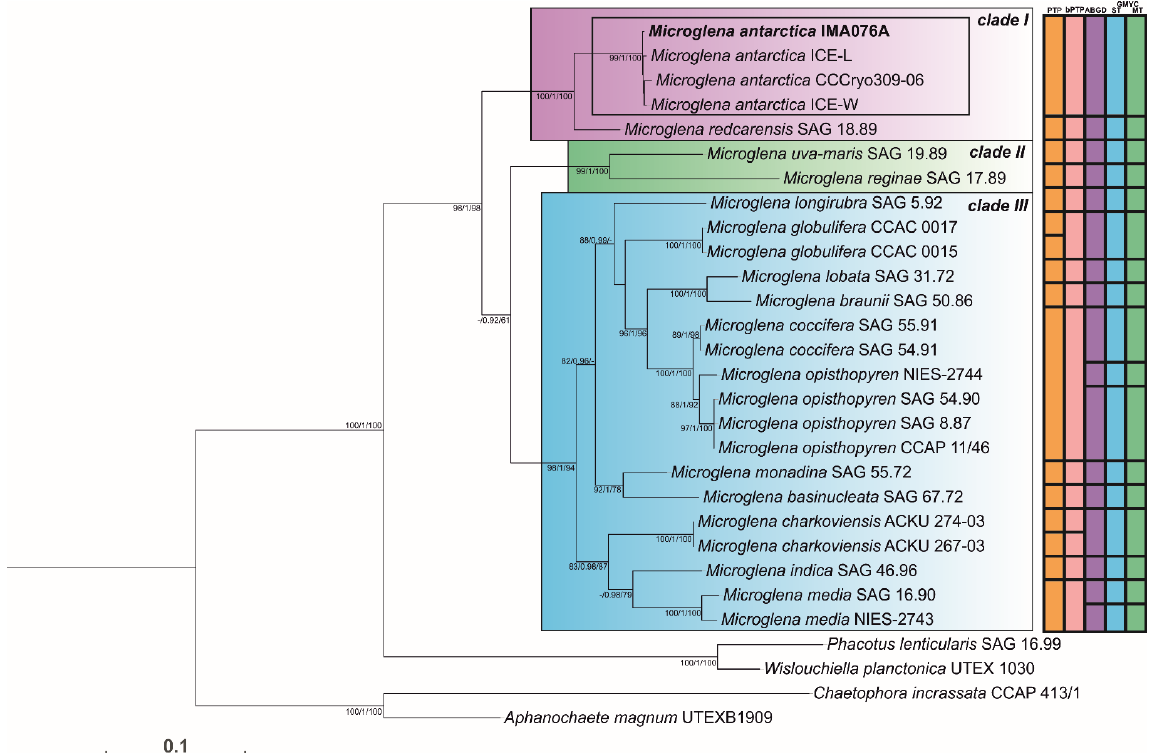
Figure 2. Maximum likelihood (ML) phylogeny of concatenated the 18S rDNA and ITS-2 regions alignment with members of the genus Microglena . Approximate Likelihood Ratio Tests based on Shimodaira-Hasegawa-like procedures (SH-aLRT) values (%), Bayesian Posterior Probabilities (PP) and ML bootstrap values (%) are shown above branches (SH-aLRT supports ≥ 80%, posterior probabilities ≥ 0.70 and bootstrap values ≥ 50%). Results of species delimitation methods: PTP = Poisson-Tree Processes and bPTP (Bayesian version), ABGD = Automatic Barcode Gap Discovery, GMYC = Generalized Mixed Yule Coalescent (ST: single threshold and MT: multiple threshold) are summarized on the right side of the tree. Table 1. Results of topology test. Scores of constrained trees: (BT) = Best unconstrained tree, (Clade I + II) = M. uva-maris , M. reginae , M. recarensis and M. antarctica . (Clade I + III) = M. recarensis , M. antarctica and freshwater Microglena species and (Clade II + R) = M. redcarensis , M. uva-maris